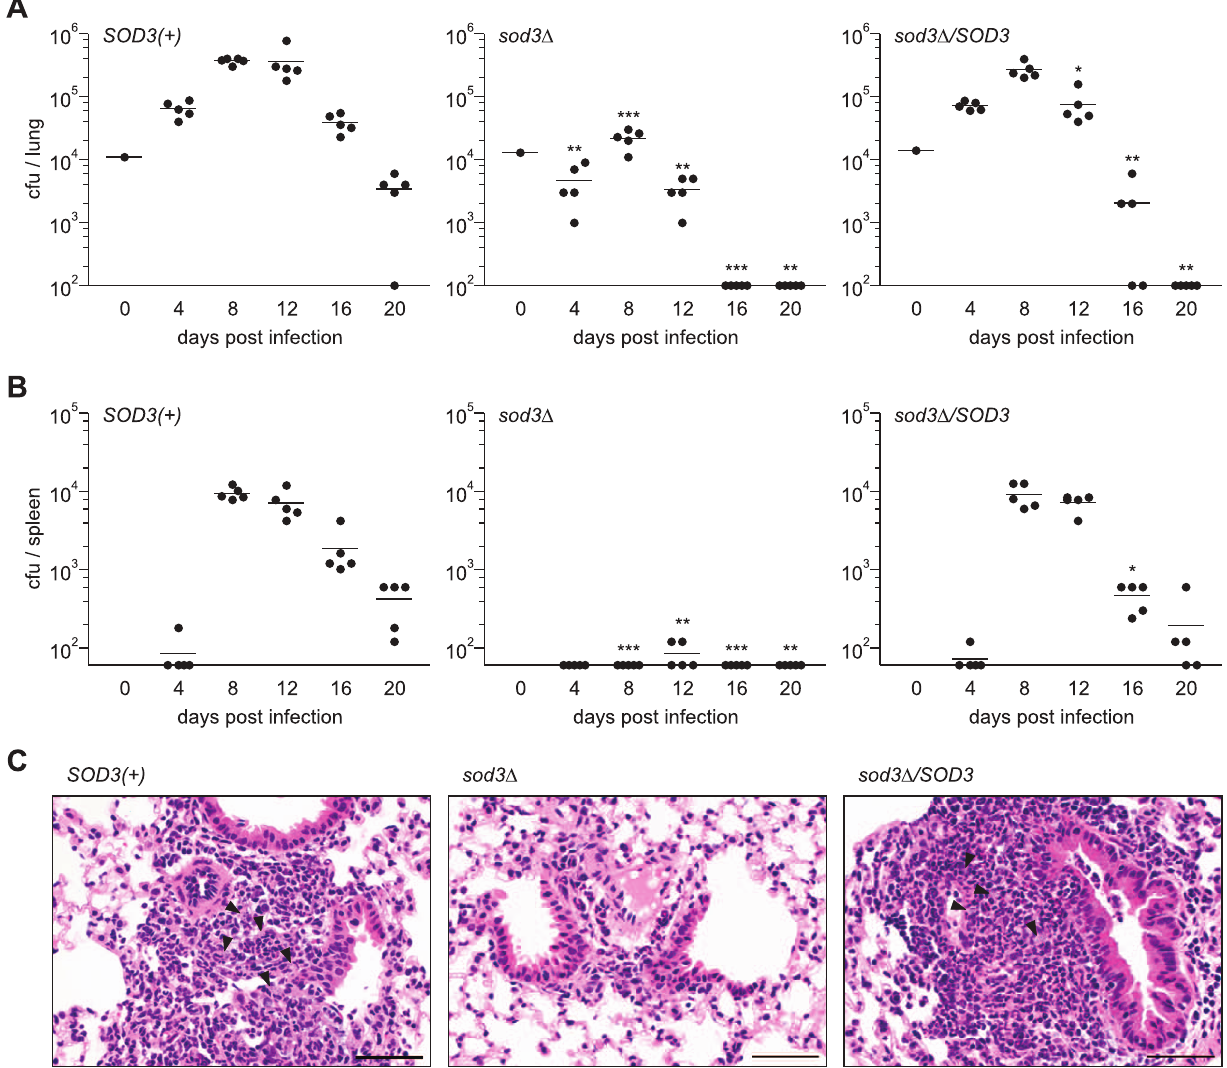
Figure 7. Histoplasma virulence in vivo requires Sod3. ( A ) Kinetics of sublethal lung infection by Histoplasma . Wild-type C57BL/6 mice were intranasally infected with approximately 1 6 10 4 SOD3( + ) (OSU45), sod3 D (OSU15), or sod D /SOD3 (OSU49) Histoplasma yeasts. At 4 day intervals post- infection, the fungal burden in lungs was determined by quantitative platings for Histoplasma cfu. ( B ) Kinetics of dissemination following lung infection with Histoplasma . At each time point, organs were harvested and the fungal burden in spleen tissue was determined by quantitative platings for cfu. In ( A ) and ( B ), each data point represents cfu counts per organ from an individual animal (n=5 per time point) and horizontal bars represent the mean fungal burden. Asterisks indicate significant differences at each time point from animals infected with SOD3( + ) organisms (* p , 0.05, ** p , 0.01, *** p , 0.001). The actual inoculum dose is shown in graphs at day 0. The limit of detection is 100 cfu for lungs and 60 cfu for spleen tissue. ( C ) Inflammation and pathology of lung tissue following Histoplasma infection. Wild-type C57BL/6 mice were infected with SOD3( + ) (OSU45), sod3 D (OSU15), or sod D /SOD3 (OSU49) yeast and at 4 days post-infection, lungs were harvested and sections stained with hematoxylin and eosin. Arrowheads indicate detectable clusters of yeast cells. Scale bars represent 50 m